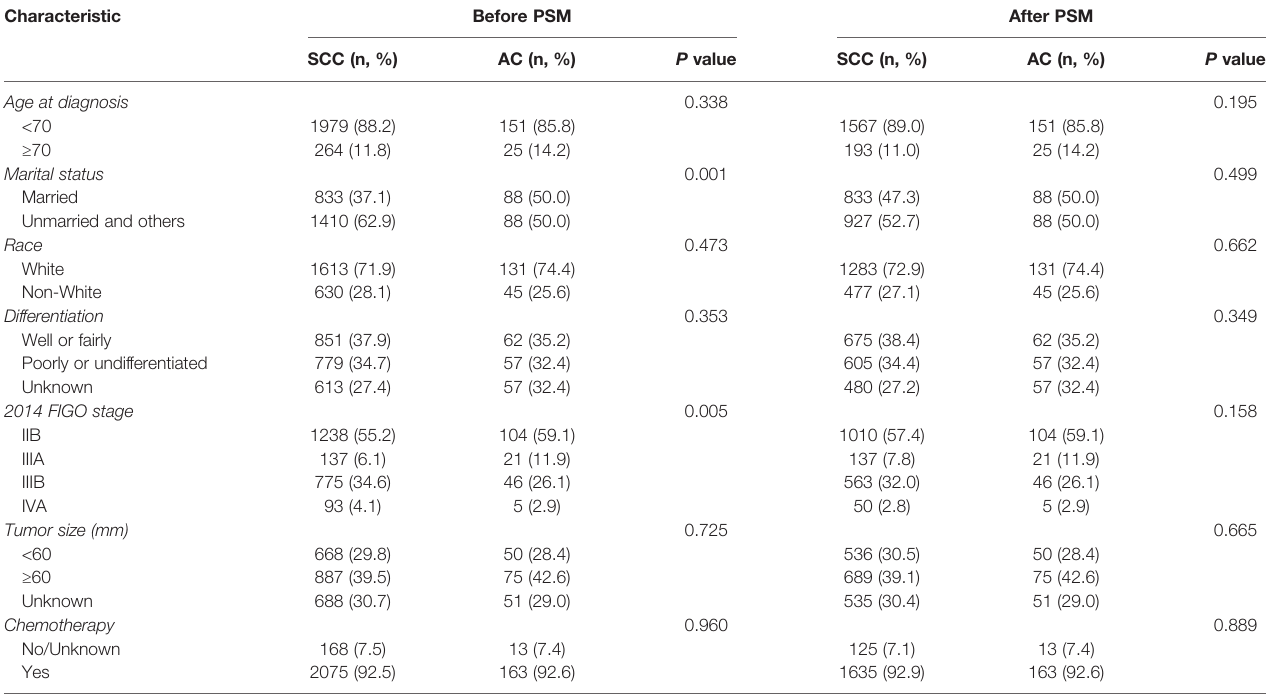
TABLE 1 | Baseline characteristics of patients with stage IIB-IVA cervix carcinoma who received EBRT and BRT.